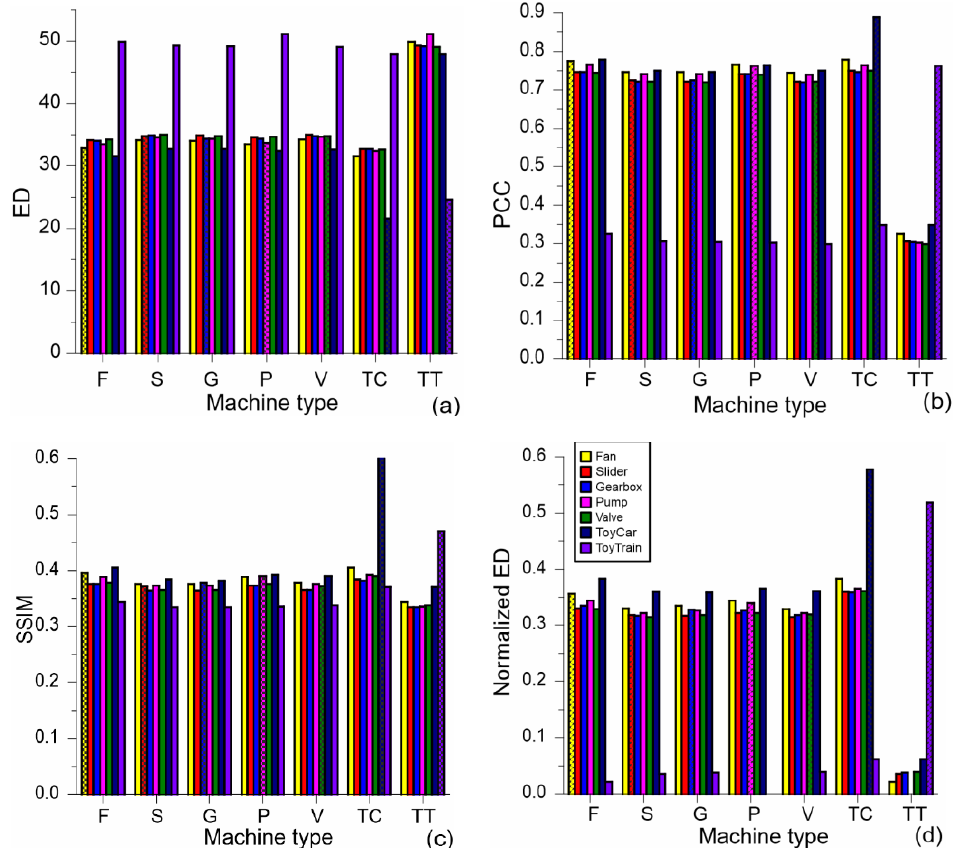
Figure 3. Mean values of intraclass (denoted by hatched bars) and interclass similarity (denoted by open bars) for the full dataset: ( a ) ED, ( b ) PCC, ( c ) SSIM, and ( d ) normalized ED (legend is the same for all plots).